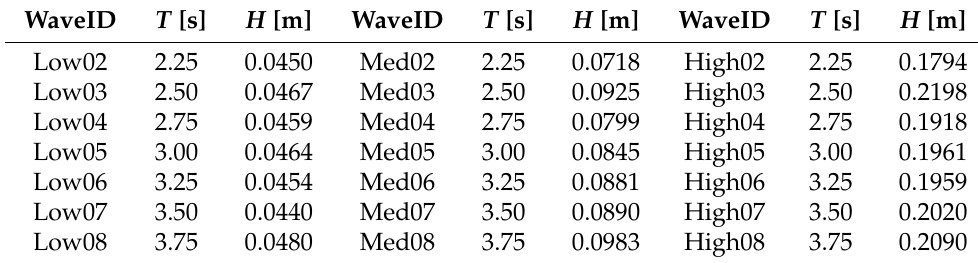
Table 1. The experimental wave